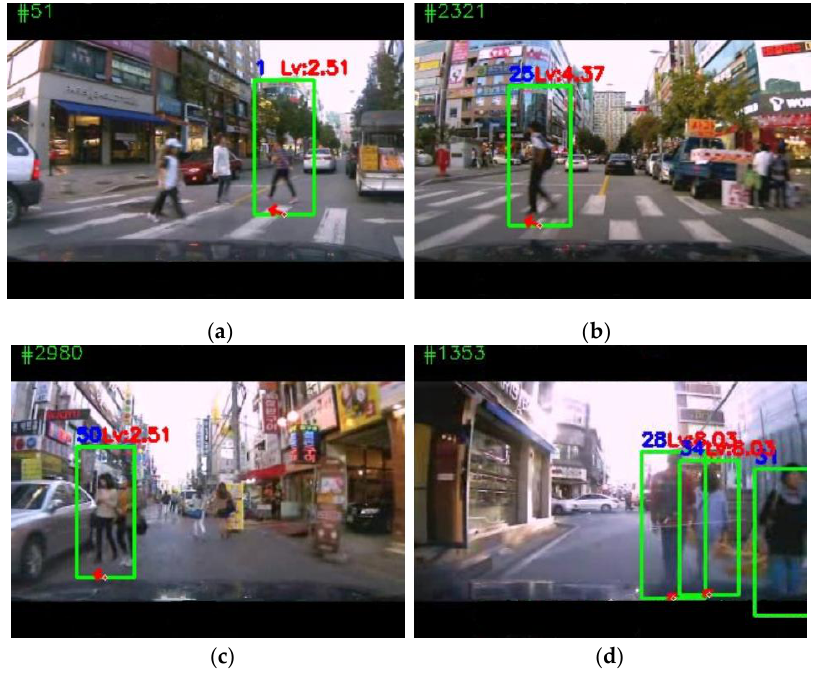
Figure 13. Some working examples of the proposed system. ( a ) Frame 51 of the APT_S1 dataset, ( b ) frame 2321 of the APT_S1 dataset, ( c ) frame 2980 of the UNIV_S1 dataset, ( d ) frame 3273 of the UNIV_S1 dataset. The results are illustrated with green bounding boxes around the detected pedestrians, the red arrows indicate the direction of pedestrian movement, and the red risk level, above the green box, was obtained from the fuzzy system. Along with the information around the boxes, the frame number and vehicle speed, as well as the calculated stopping distance at that time, are displayed on the top border above the image. The estimated pedestrian position, distance from the vehicle, and the direction of movement are displayed on the border below the image.